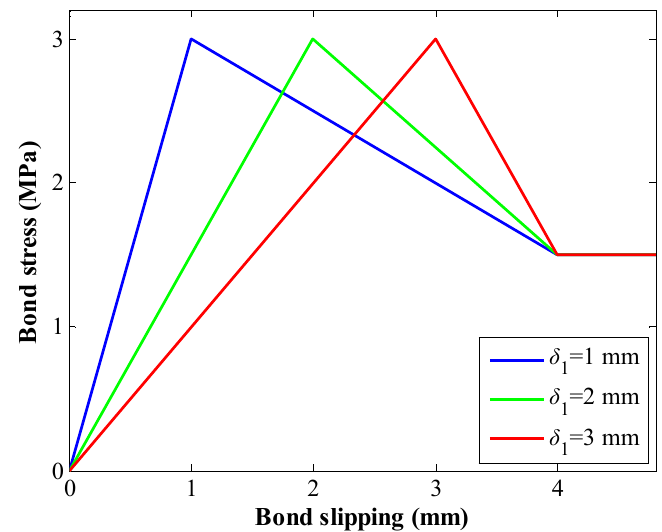
Figure 14. Inputted tri-linear equation.